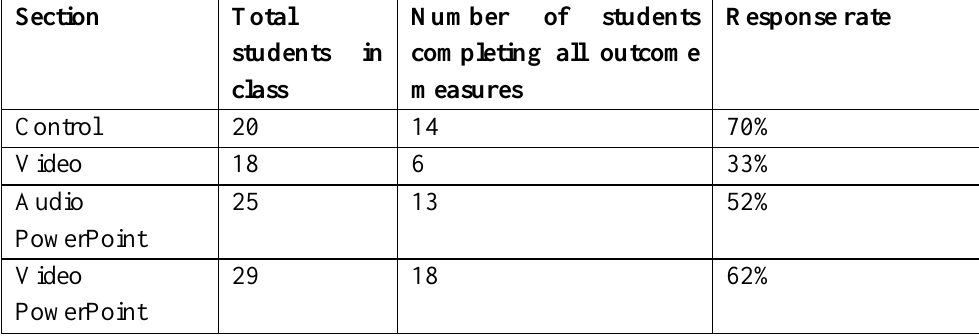
Total Students and Students Responding per